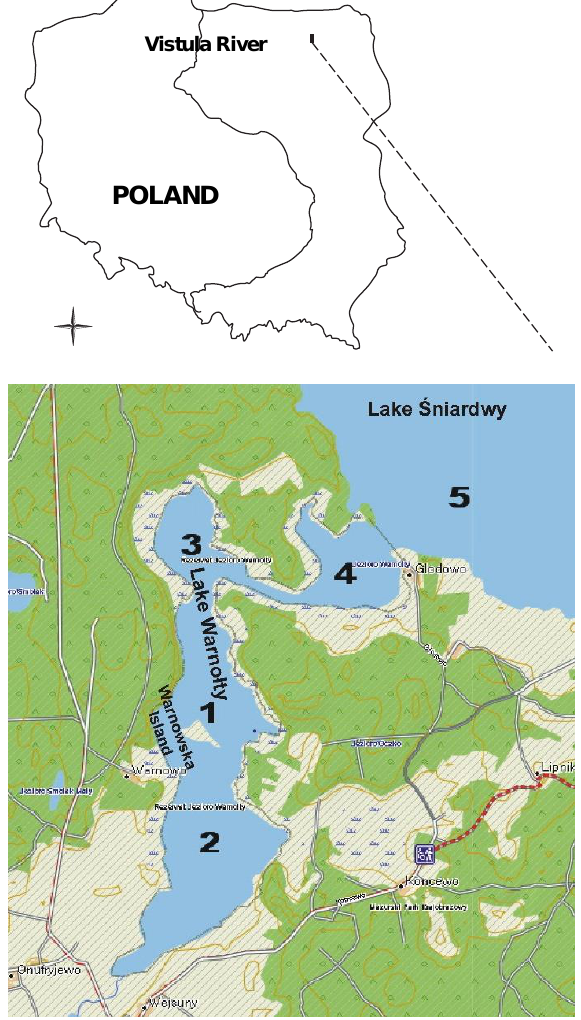
Figure 1. Location of sampling sites in Lake Warnołty (sites 1 – 4) and Lake Śniardwy (site 5). The biological parameters included